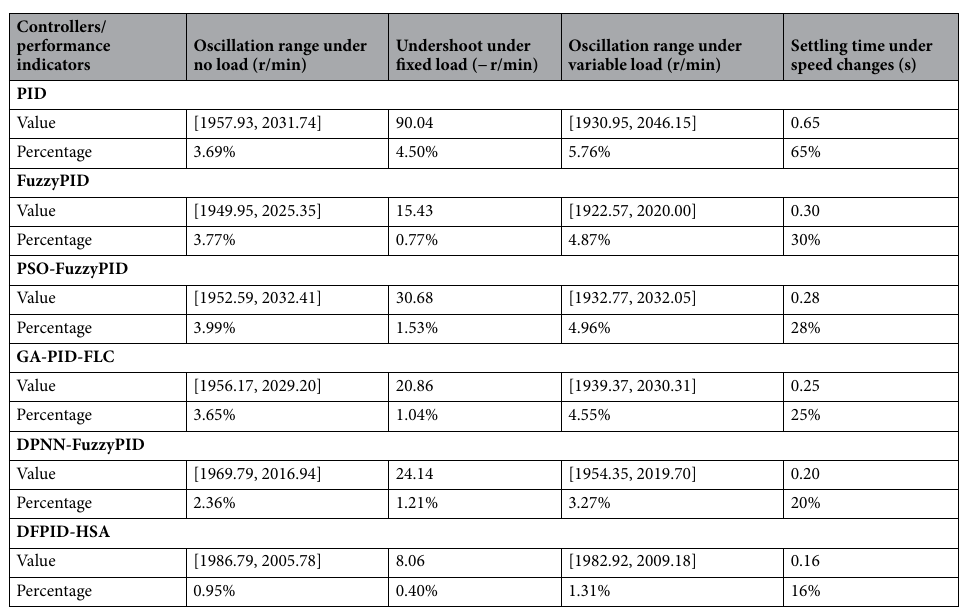
Table 11. The comparison of performance indicators under different